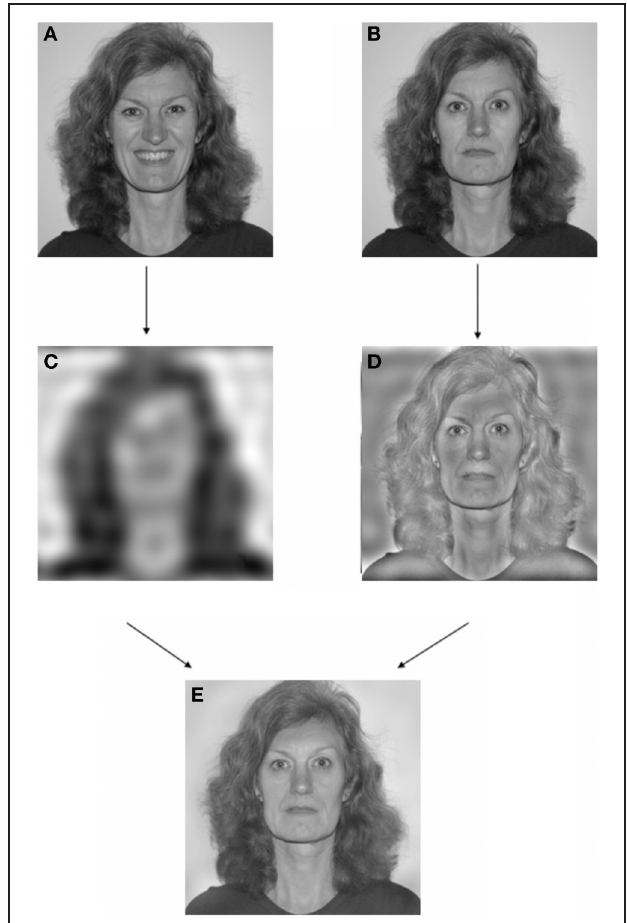
FIGURE 1 | An example of the editing procedure used to obtain a hybrid expressive face. Image (A) and (B) are separate photographs of the same individual assuming a “happy” and “neutral” expression, respectively. Image (C) is the low-passed version ( < 6 cycles/image) of Image (A) , whereas Image (D) is the high-passed version ( > 7 cycles/image) of Image (B) . Image (E) is the hybrid picture or a combination of images (C,D) with a happy expression embedded exclusively in the lowest spatial frequencies. Nota Bene: images in this illustration are printed at a size smaller than the one used in the actual experiment and the person appearing in this example is not one of the stimulus faces from the Karolinska facial stimuli set and her face was not shown in the